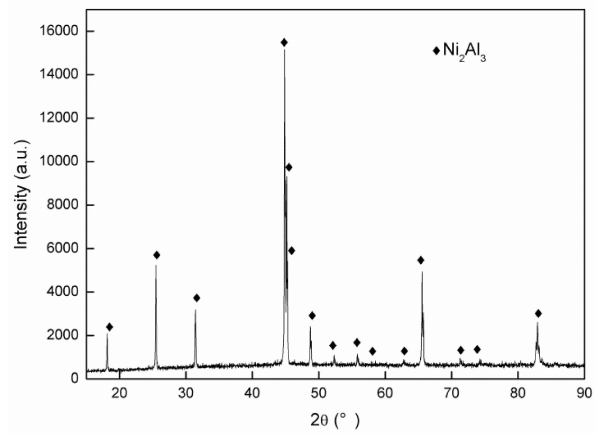
Figure 1. The XRD pattern of the Ni 2 Al 3